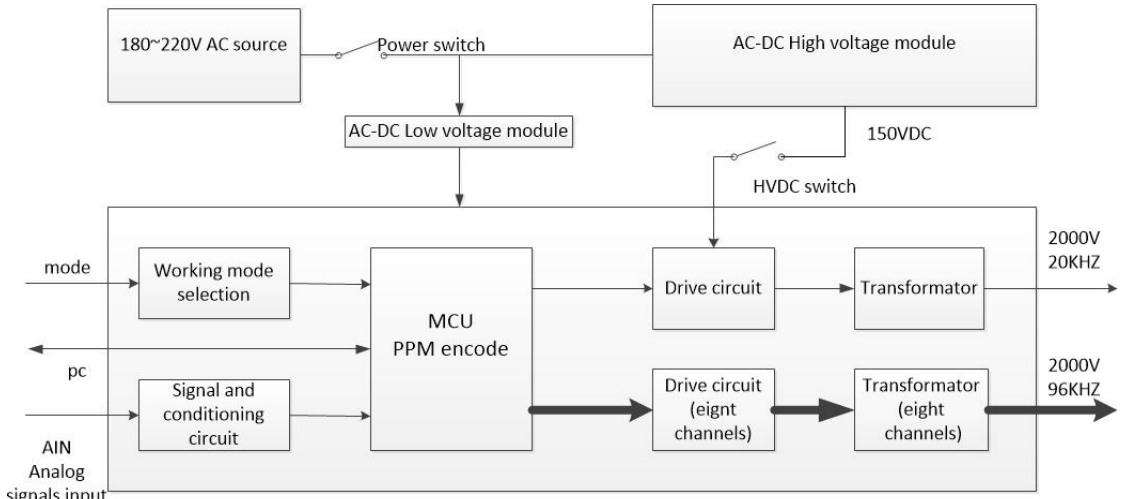
Figure 2. Architecture of the proposed stress wave communication system